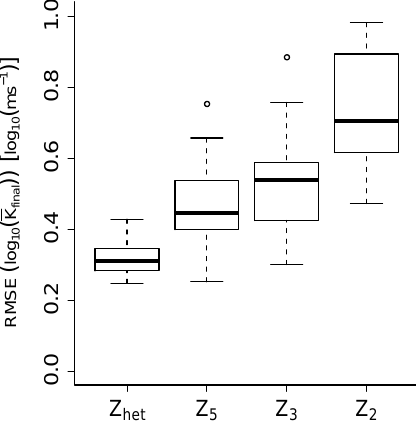
Fig. 17. Statistics of root mean square error of mean hydraulic con- ductivity (RMSE ( log 10 ( ¯ K final )) ) after the last update step calcu- lated from all references of scenario